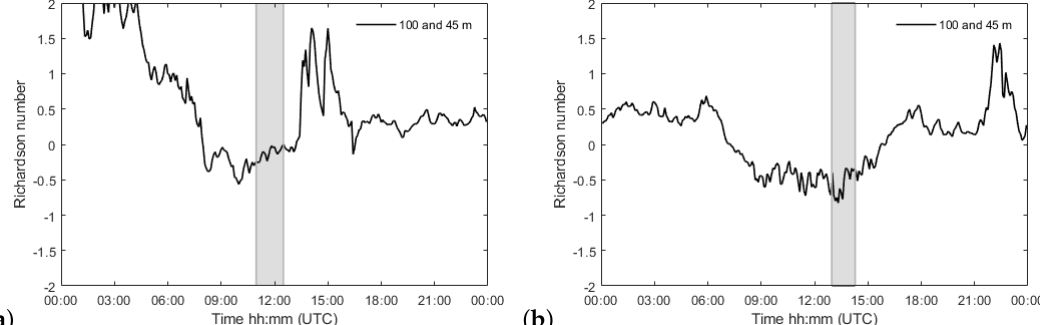
Figure 13. Time series of 10-min averages of the Richardson number on 21 ( a ) and 22 ( b ) September. See also Figure